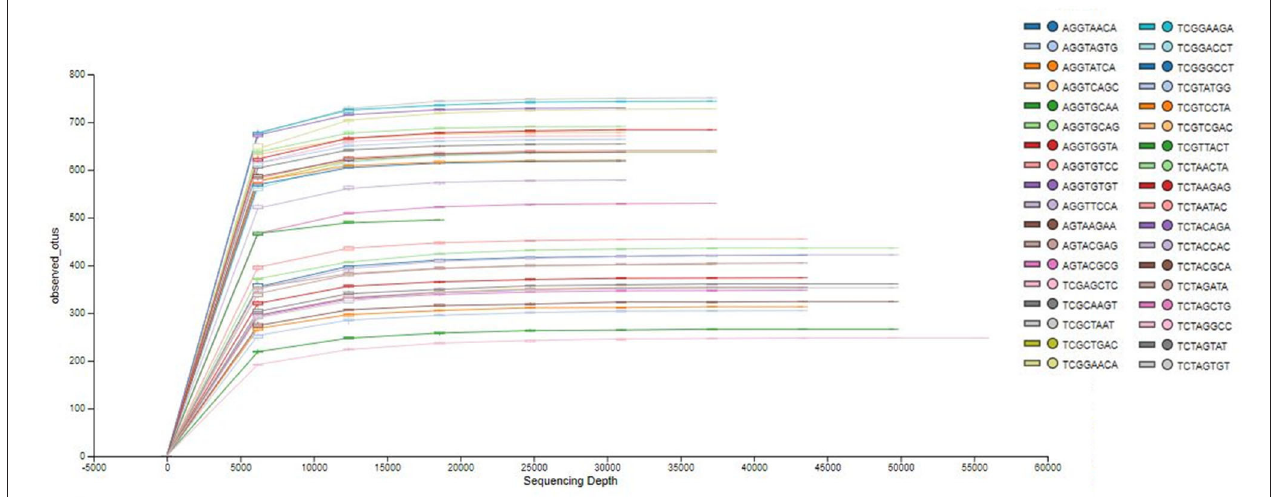
FIGURE 1 | Phylogenetic rarefaction curves estimating species richness. The rarefaction curves produce smoother lines facilitating full dataset comparison by reaching a clear